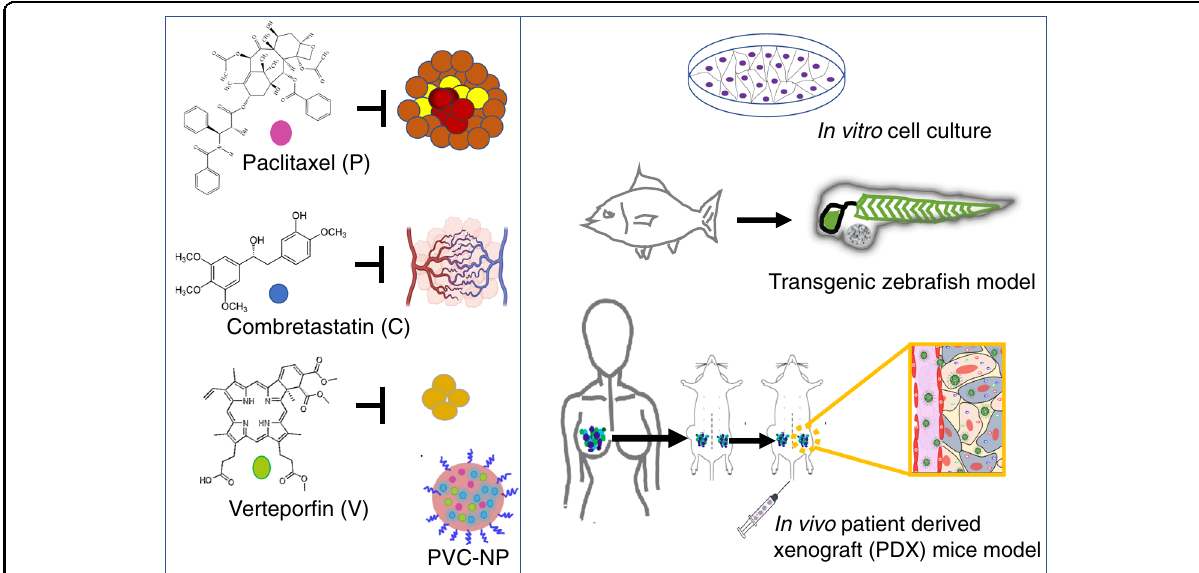
Fig. 7 A schematic representation of experimental design using cell culture, transgenic zebra fi sh, and patient-derived xenograft models to study bulk cancer cells, angiogenesis, and CSCs. PDX: established TNBC PDX fragments were isolated from mice, and engrafted in mice again for in vivo transplantation and for in vitro organotypic slice culture. Biorender was used to construct part of the fi